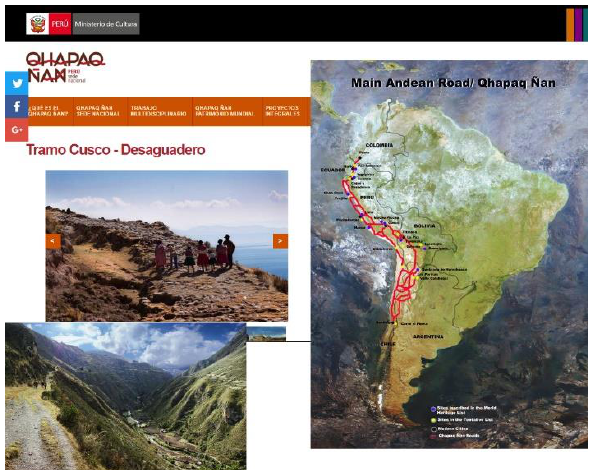
Figure 20. Sections, cultural landscape and map of the Andean Road System. . © Project Qhapaq Ñan – Sede Nacional, 2017. Ministerio de Cultura, Gobierno de Perú. UNESCO World Heritage Figure 17. View of the Inca Bridge of Qeswachaca - Peru. © US Dept. of State Geographer. GOOGLE. Image: Screen capture, 2017. Google Earth.